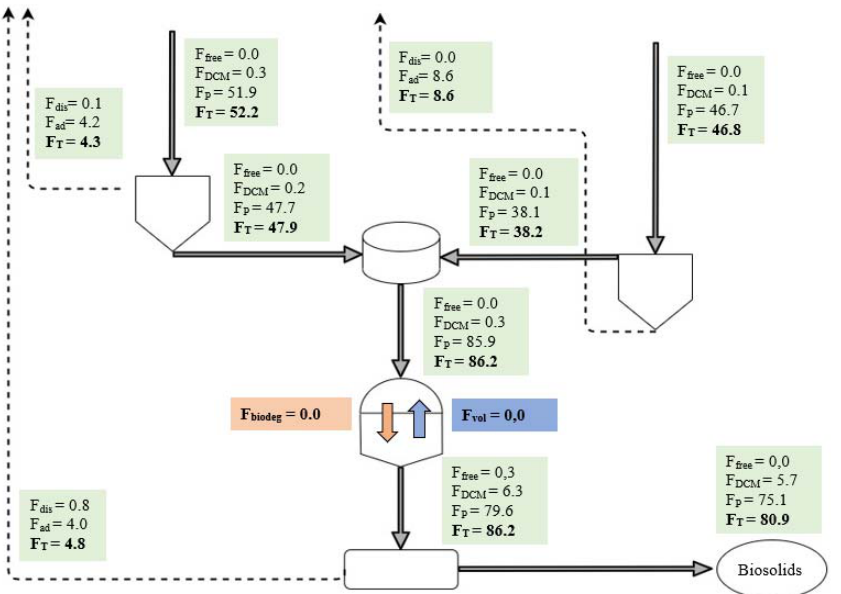
Figure 6. Fate of benzo(a)pyrene in the sludge line. Results are presented in g/day. F dis is the resulting load in the dissolved phase, F free is the freely dissolved, F DCM is sorbed to the dissolved and colloidal matter (DCM), and F p is sorbed to particles.